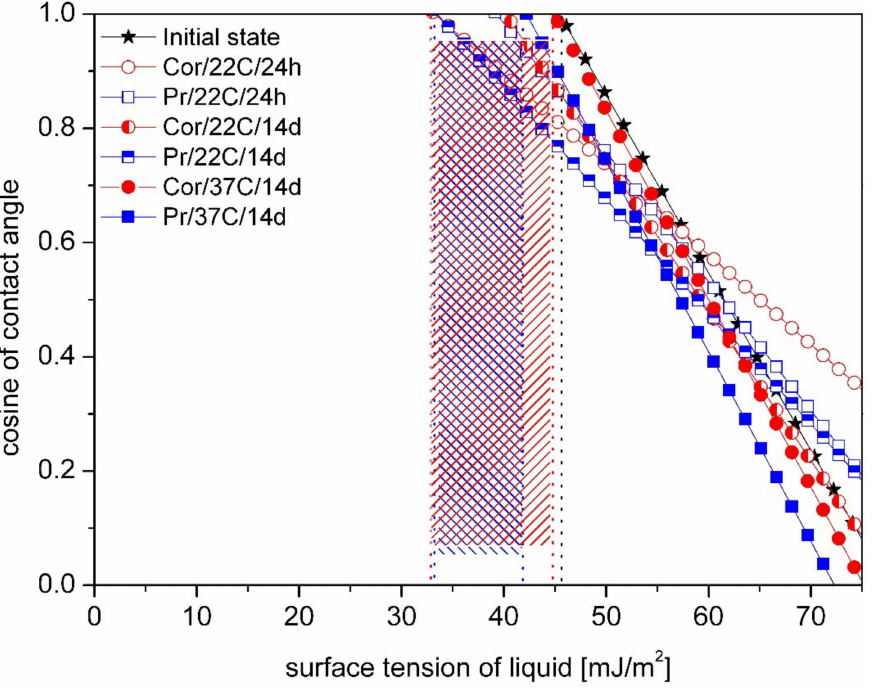
Figure 5. Comparison of the medium influence on the critical surface free energy (marked with vertical lines) for Villacryl H Plus obtained by Zisman’s method. The hatched area shows the difference of γ C between samples in the initial state and after storage.